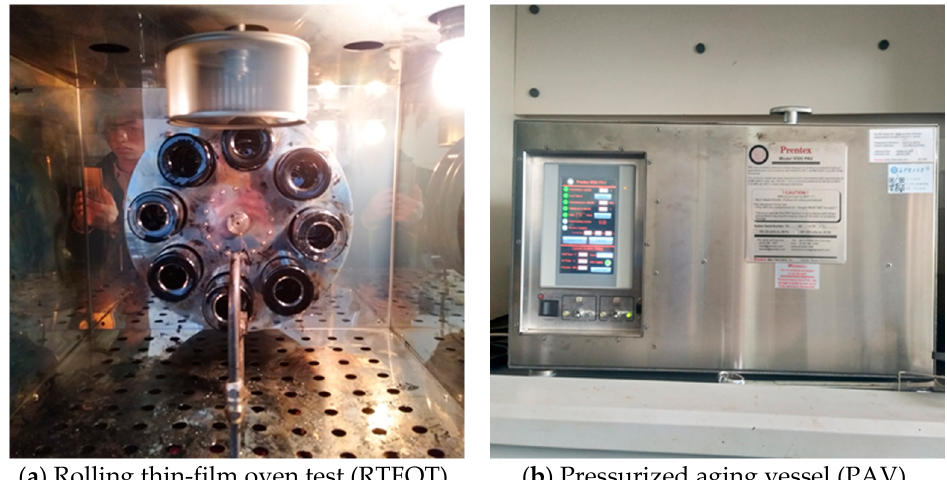
Figure 4. Aging test equipment.